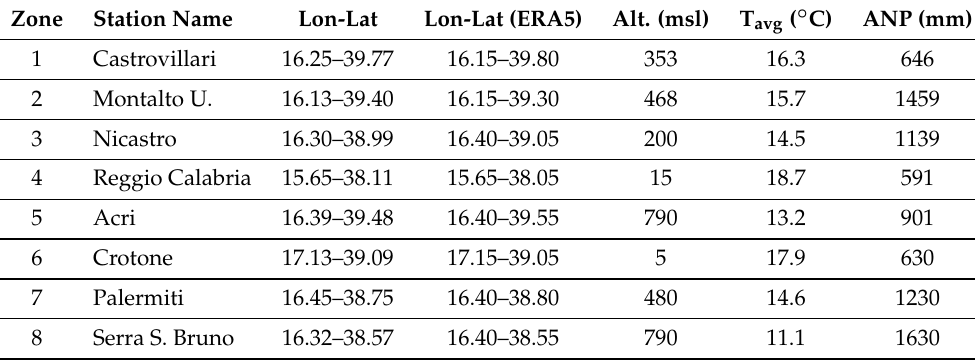
Table 1. The eight zones and the related representative stations/ERA5 points used in the analysis. Longitude, latitude and altitude (only for observational stations) are also reported. The positions of each station for each zone are identified by the blue filled circles in Figure